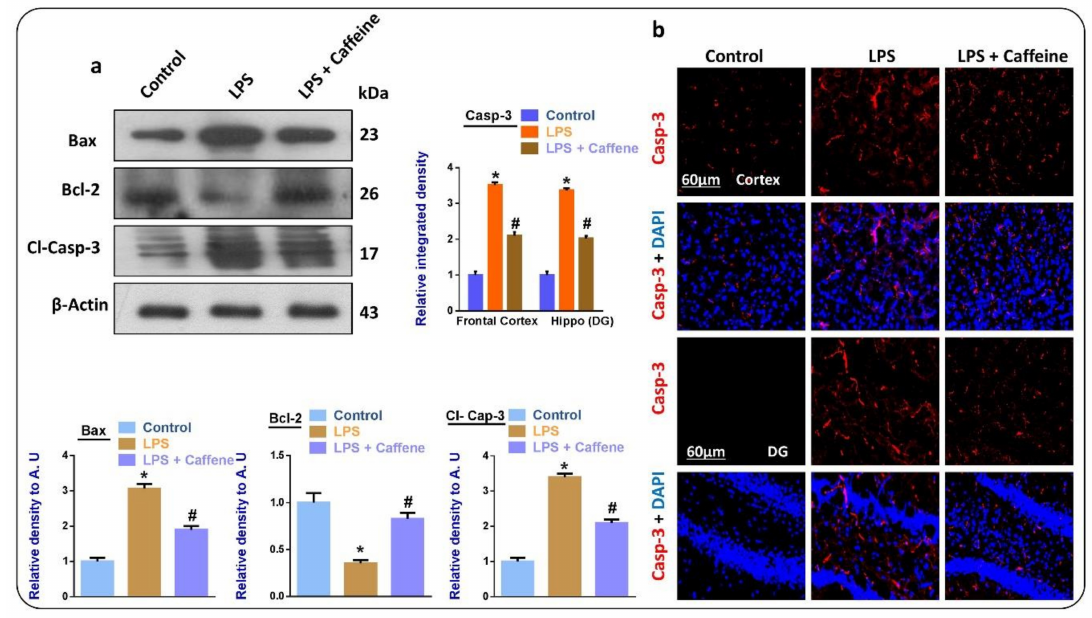
Figure 4. Ca ff eine inhibits mitochondrial apoptosis in the LPS-injected mice: ( a ) Western blot results of BCL2-associated X, apoptosis regulator (Bax), B-cell lymphoma 2 (Bcl-2), and